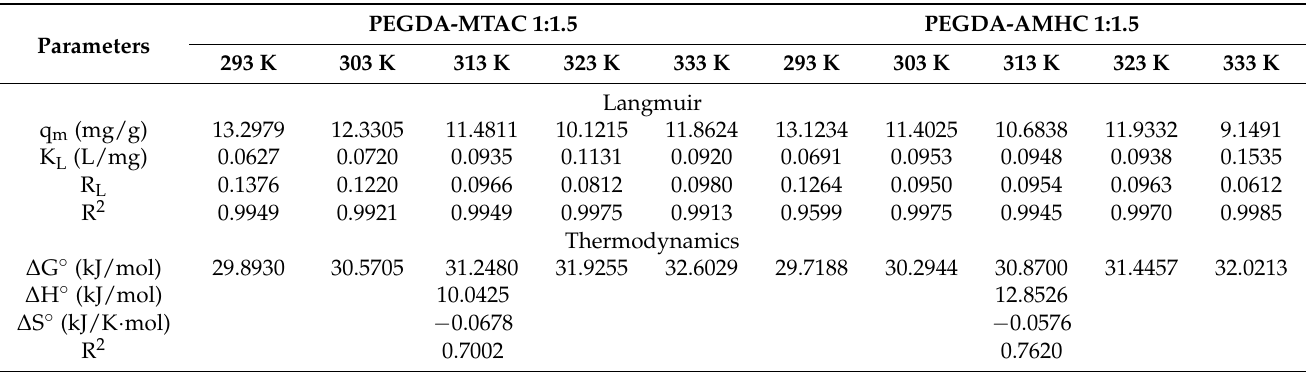
Table 6. Langmuir isotherm and thermodynamic parameters for adsorption nitrite by M 1.5 and N